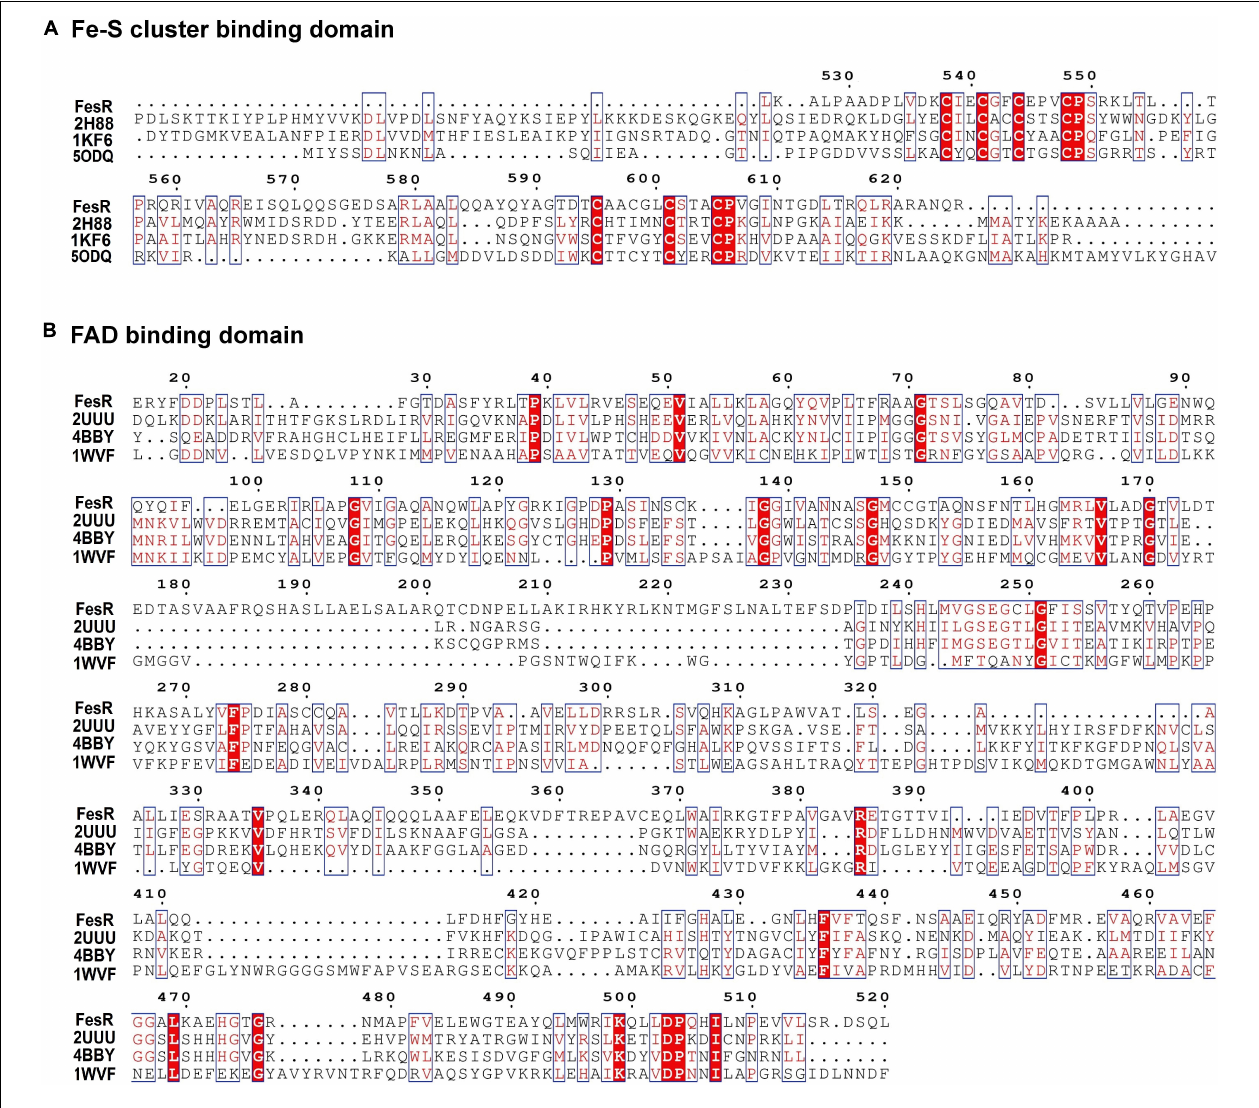
FIGURE 1 | Multiple sequence alignment of flavin adenine dinucleotide (FAD) (A) and Fe-S cluster (B) conserved binding domains. Predicted FAD (16–520 aa)- and 4Fe-4S cluster (525–625 aa)-binding sites were used to search in the HHpred server. The results showed that FesR shared high similarity in the FAD-binding domain with 2UUU, 4BBY, and 1WVF and high similarity in the 4Fe-4S cluster-binding domain with 2H88, 1KF6, and 5ODQ. These proteins were downloaded from the PROTEIN DATA BANK (PDB) and were used for further sequence alignment. Identical residues are shown in red background, and highly similar residues are shown in the red boxes. Arg385 might be involved in FAD binding, while Cys538, Cys541, Cys544, and Cys548 might be responsible for 4Fe-4S binding and Cys595, Cys598, Cys601, and Cys605 responsible for another 4Fe-4S binding according to the sequence analysis results and the literature (Landry and Ding, 2014).